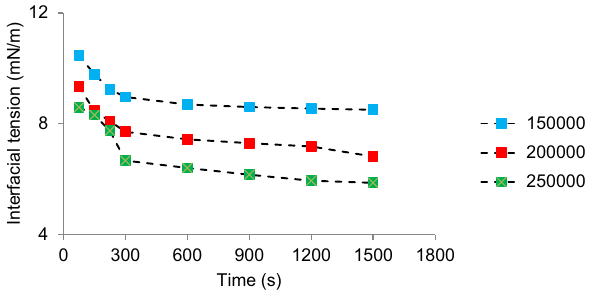
Fig. 9 Dynamic interfacial tension curves of TR-880 solution at a concentration of 25 ppm and salinity from NaCl dissolution at vari- ous concentrations at 351.15 K and 14.7 psi